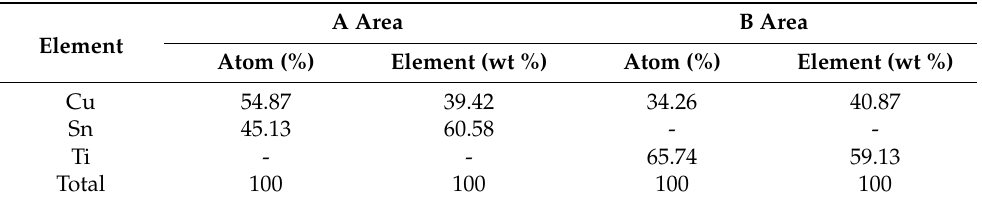
Table 1. Energy dispersive spectroscopy (EDS) analysis of area A and area B in Figure 7.